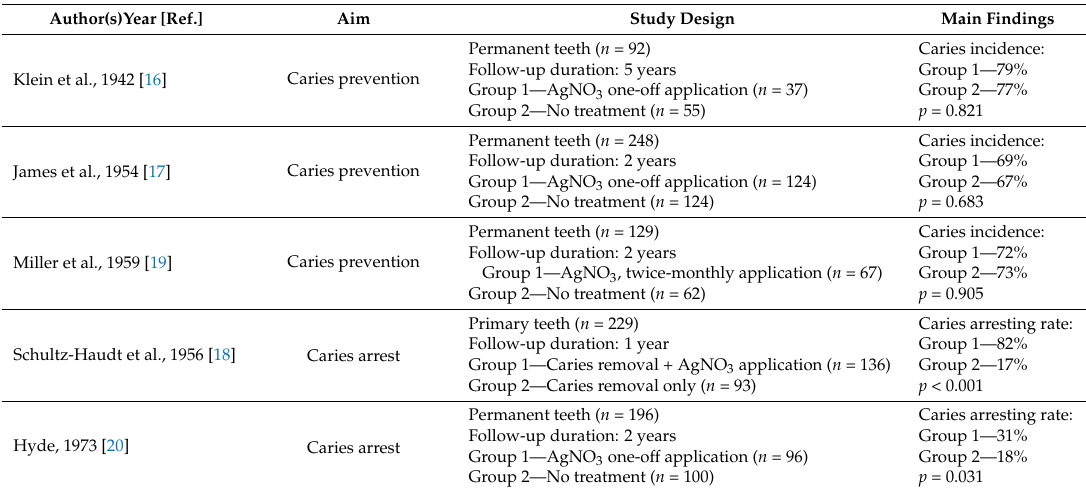
Table 1. Clinical trials of silver nitrate for caries